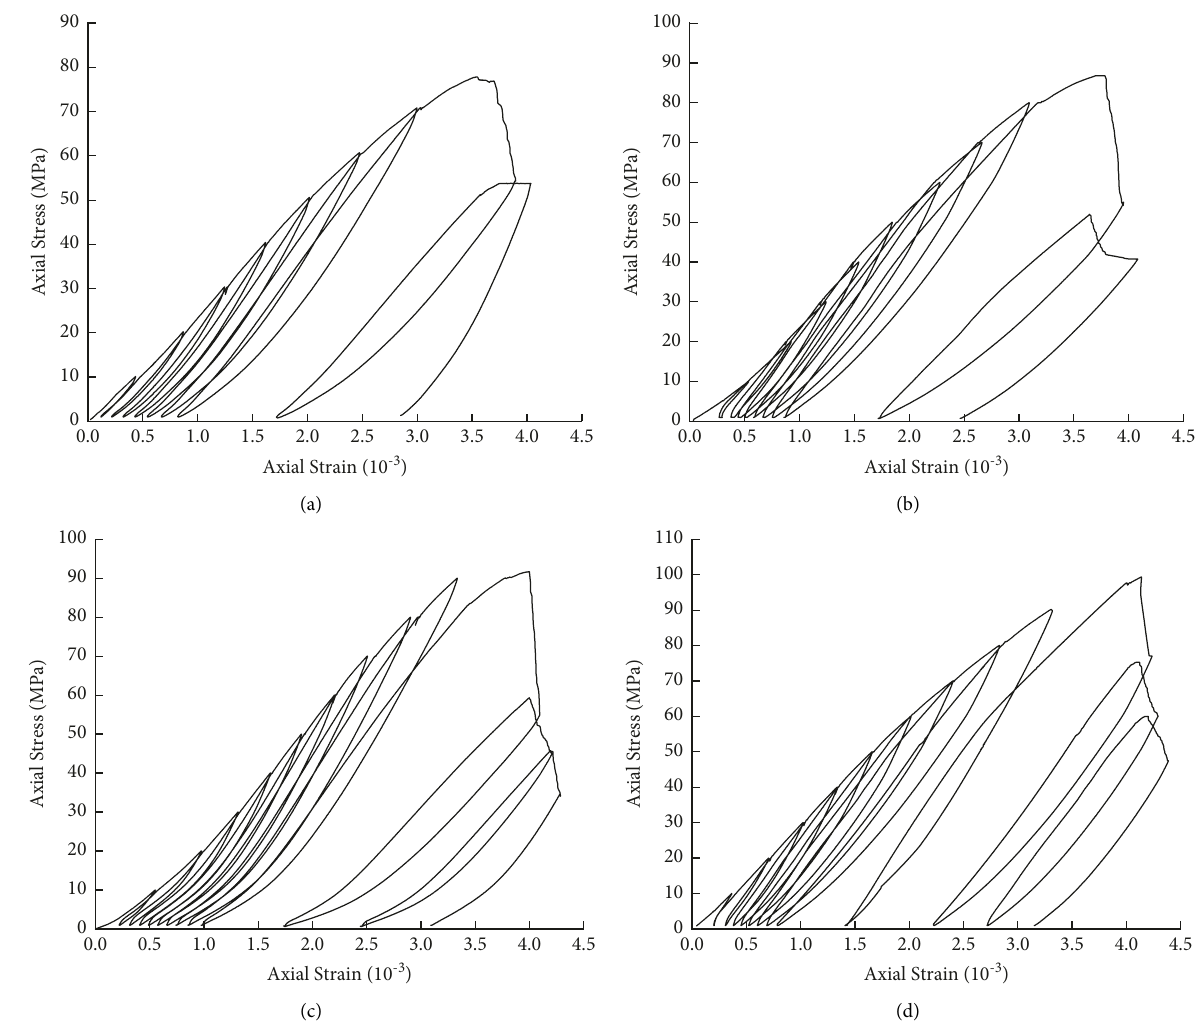
Figure 5: The axial stress-axial strain curves of typical shale